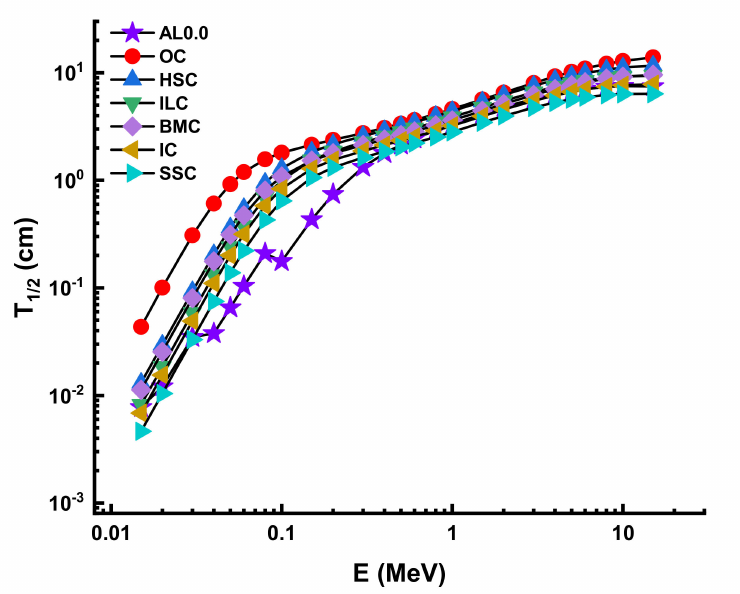
Figure 14. Half-value layer comparison between some concretes and AL0.0